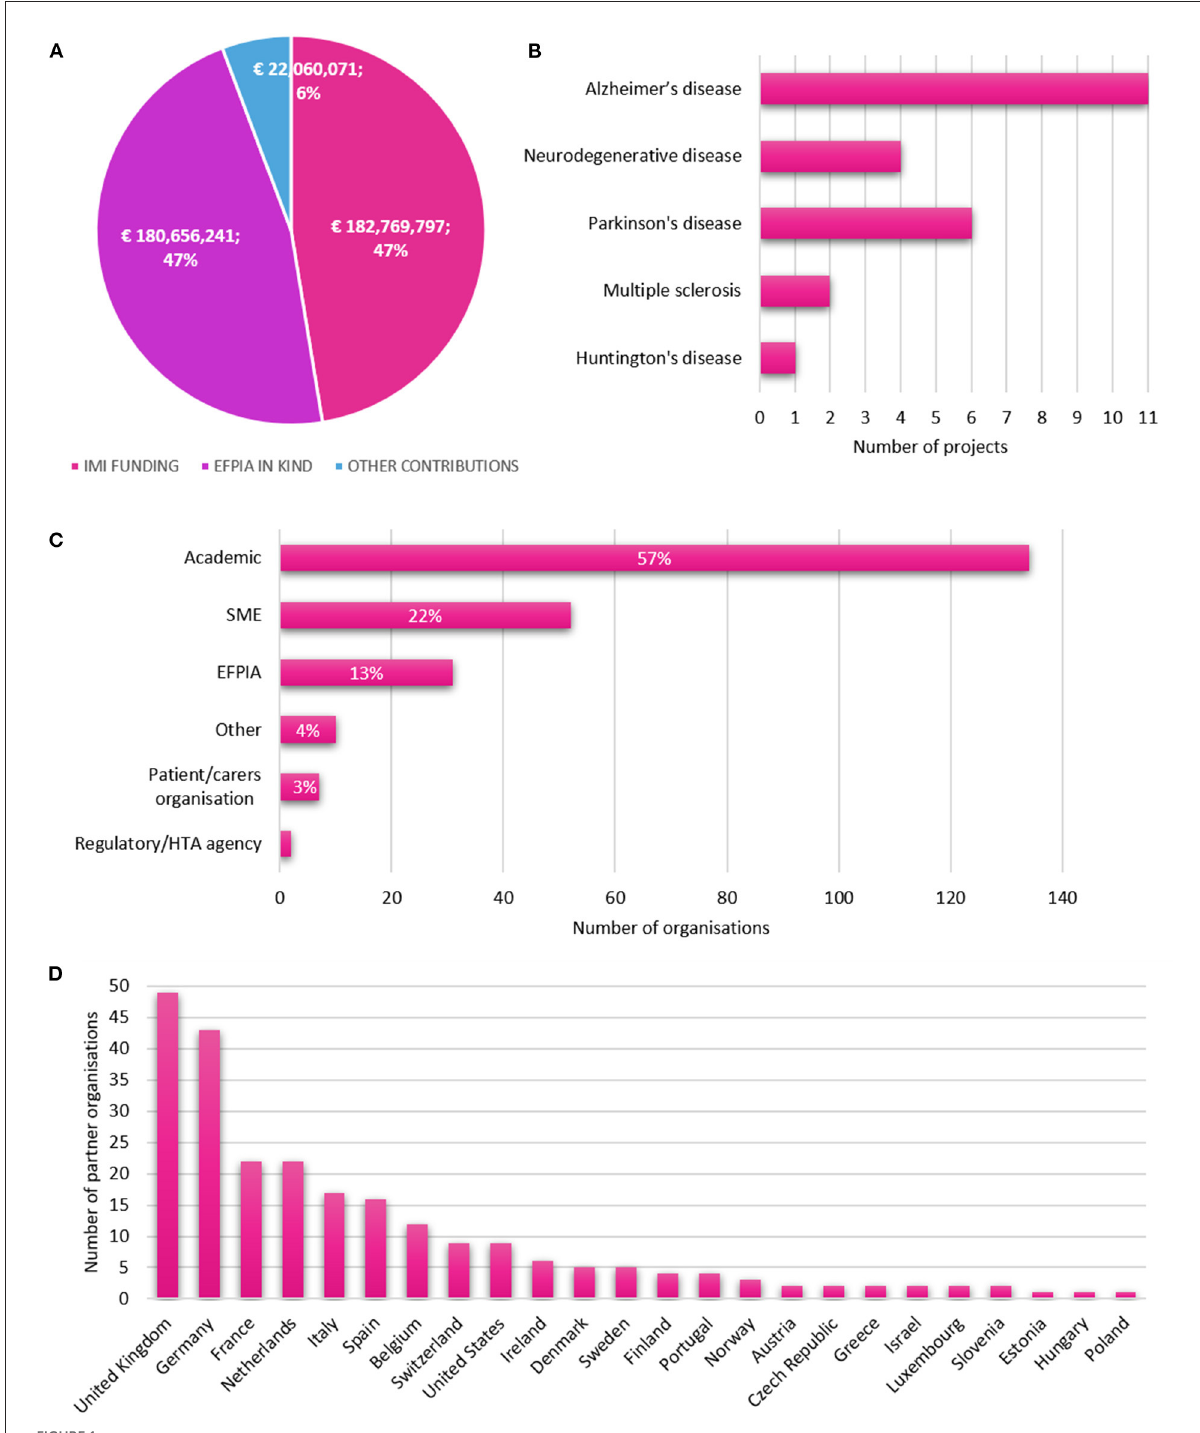
FIGURE1 IMI neurodegenerative disease portfolio characteristics. A set of project parameters was collected for 18 projects in the IMI Neurodegenerative disease (NDD) portfolio from sources including EU databases, project websites and descriptions of work. (A) Total funding contributions for the IMI NDD portfolio, by source and amount. (B) Disease areas targeted by IMI NDD projects; number of projects. (C) Types of partner organisations in IMI NDD projects; number of organisations, by category. (D) Countries of partner organisations; by